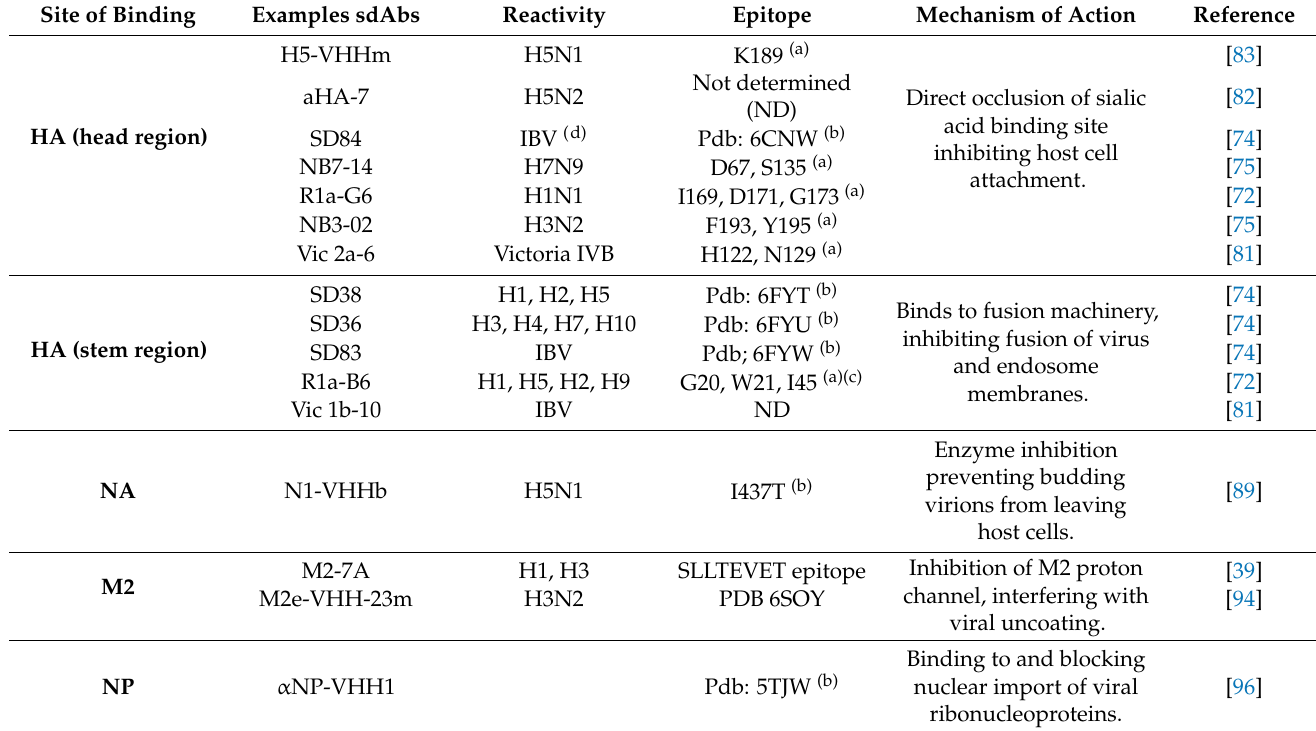
Table 1. Single domain antibodies against influenza and their mechanism of